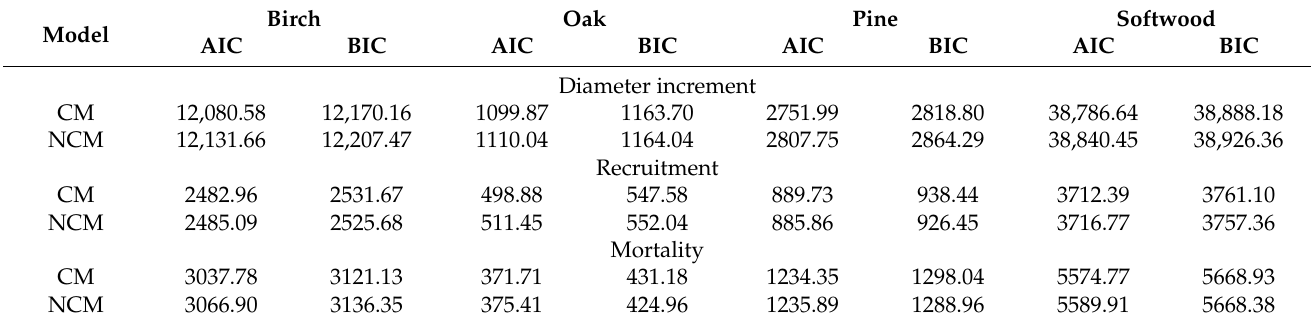
Table 7. Model comparison in terms of goodness-of-fit represented by AIC and BIC.